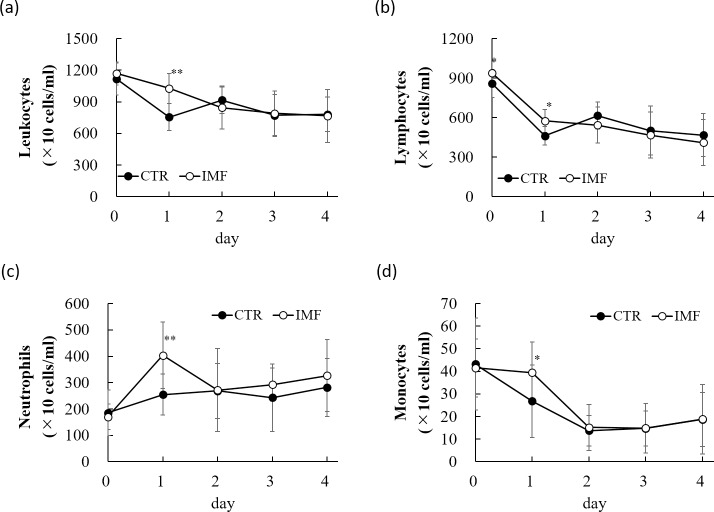
The counts of total leukocytes, lymphocytes, neutrophils, and monocytes after 5-FU injection.(a) total leukocyte counts, (b) lymphocyte count, (c) neutrophil count, and (d) monocyte count. Values are means ± standard deviations. * P < 0.05, ** P < 0.01, vs. CTR group.